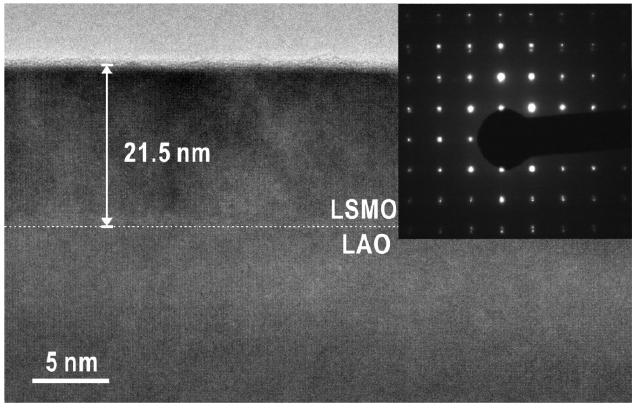
Figure 5. Low magnification of cross-section TEM image and SAED pattern covering both film and